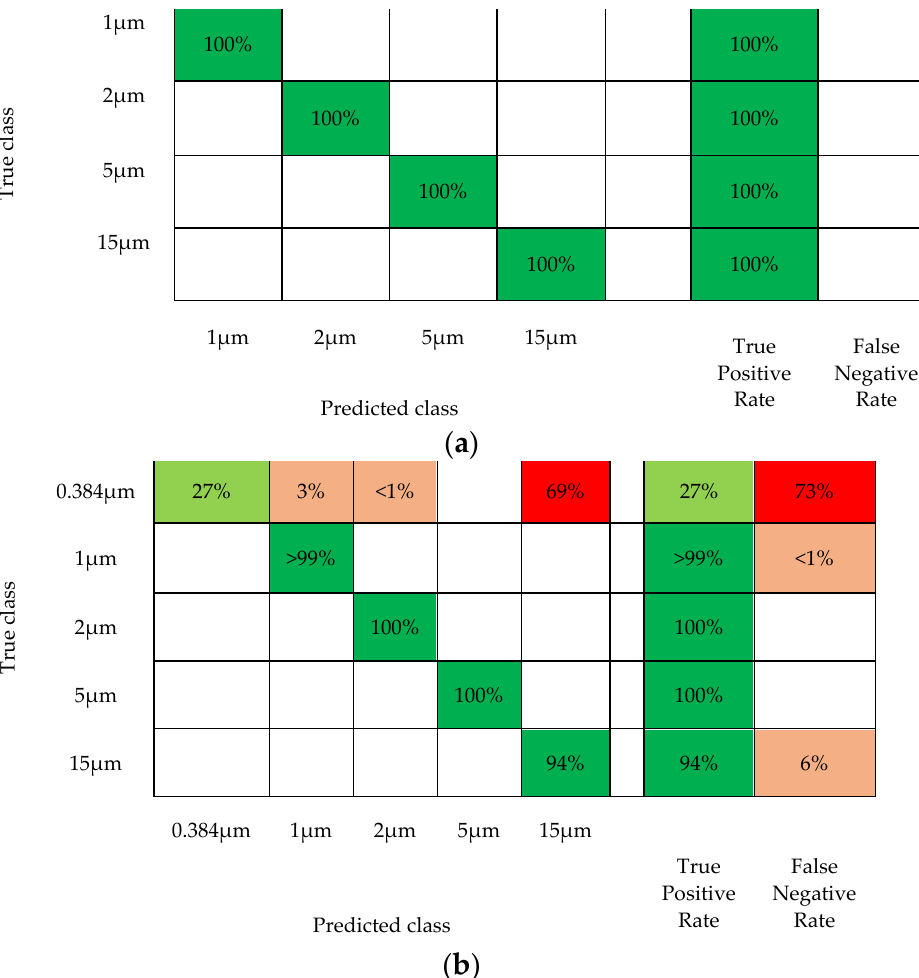
Phantoms with Ø 1 µ m, 2 µ m, 5 µ m and 15 µ m of latex beads could be categorized correctly in 100% of cases using SVM with and without PCA (Figure 6a). However, the level of discrimination was significantly reduced with submicron PBs (384 nm), where only